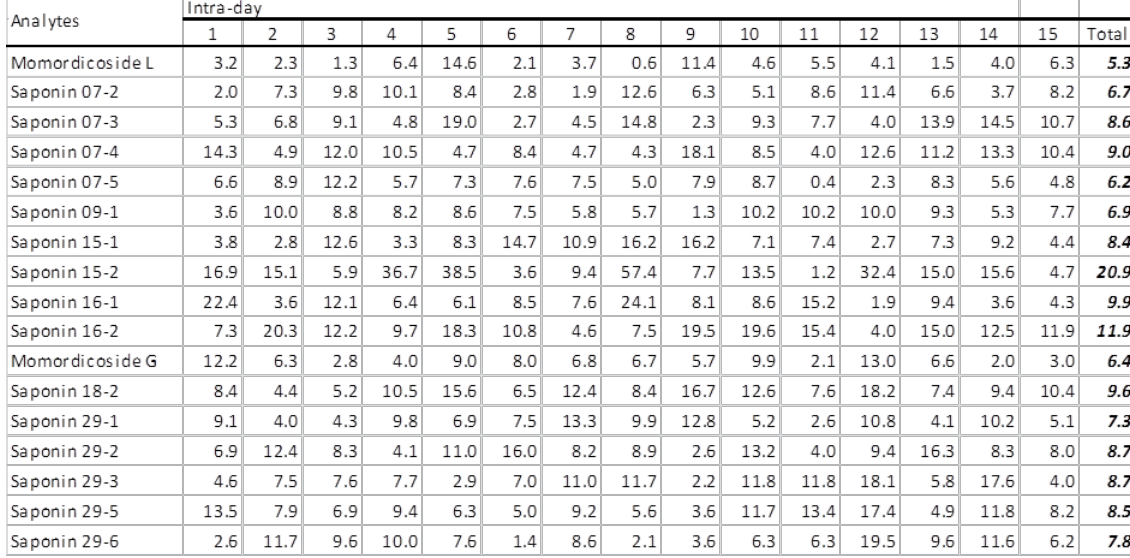
Table S3: Intra-day (n = 4) and total (n = 60) repeatability as CV values of saponin compounds in QC samples after signal intensity drift/batch correction